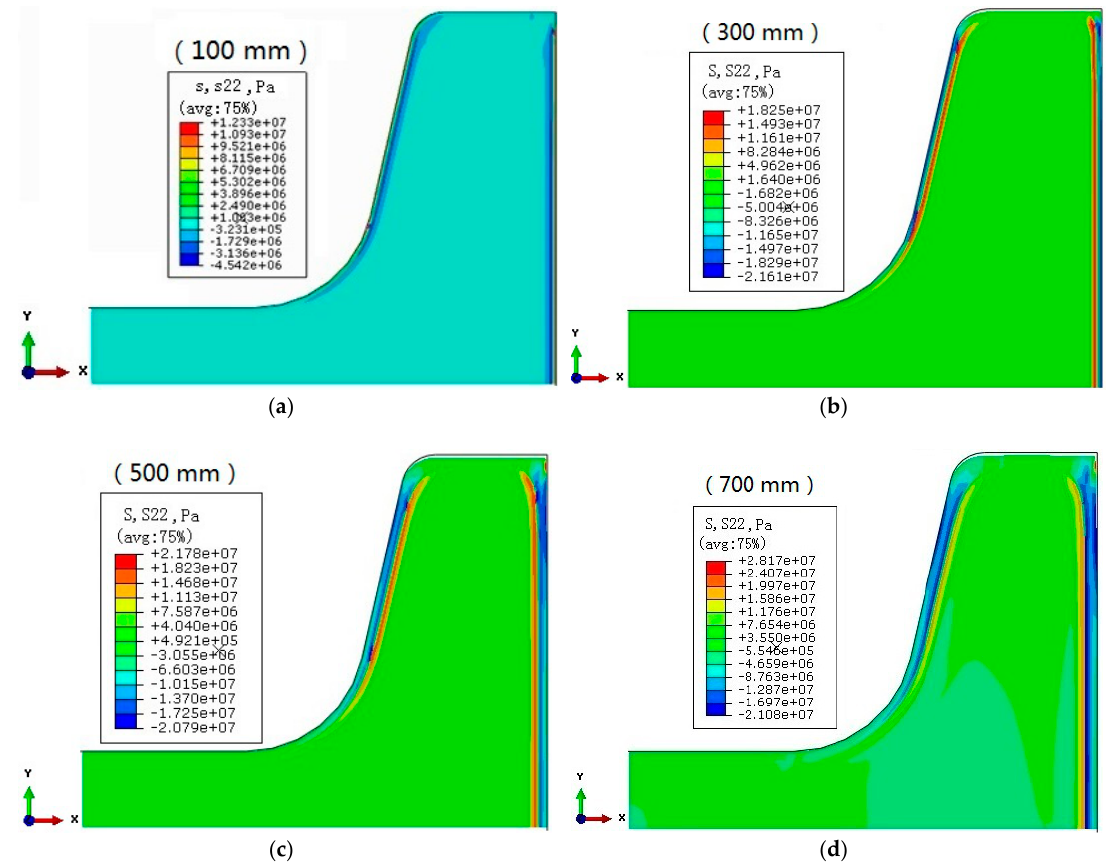
Figure 10. Stress contours along Y direction at depths from the meniscus of ( a ) 100 mm; ( b ) 300 mm; ( c ) 500 mm and ( d ) 700 mm in the mold.